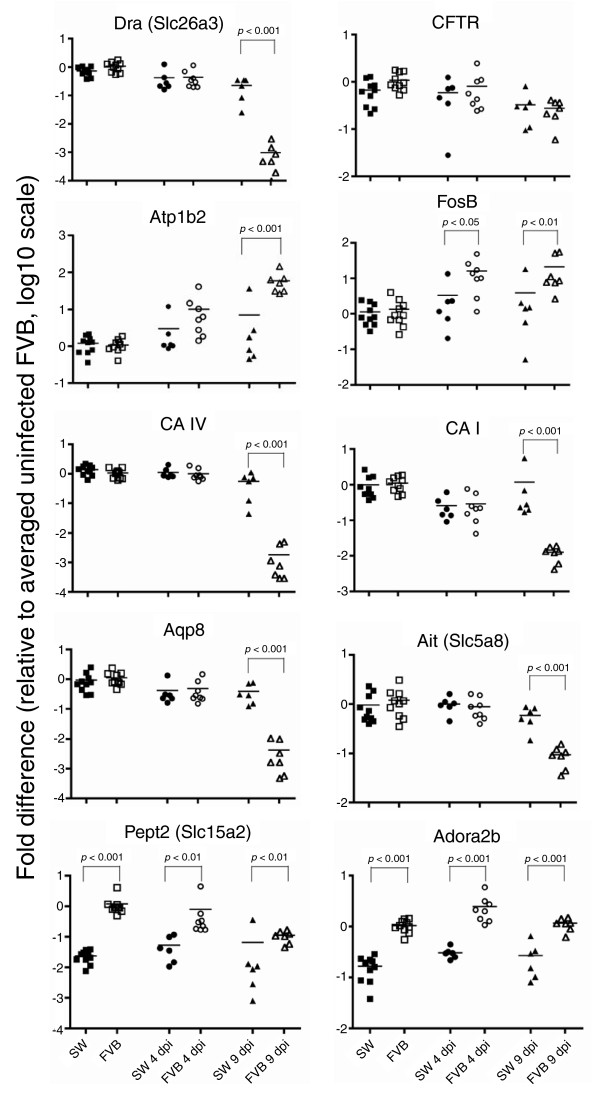
qRT-PCR of genes involved in intestinal transport and its regulation. The expression of genes was normalized to uninoculated FVB mice. Each symbol represents one animal. Lines indicate group means.